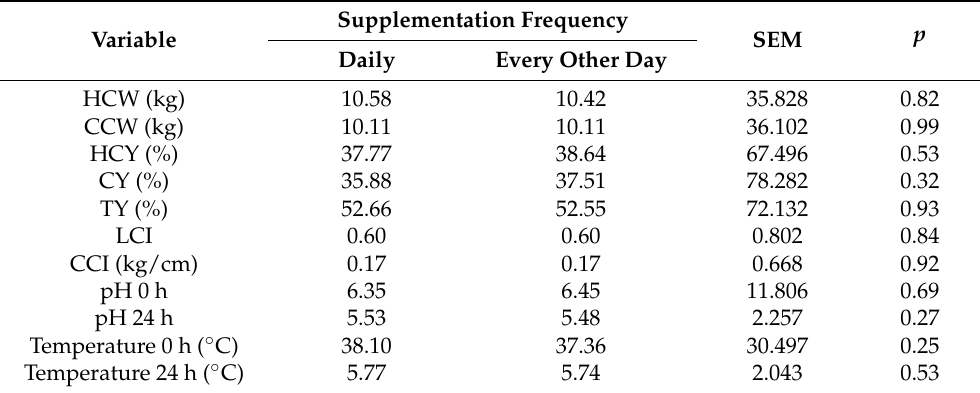
Table 5. Carcass characteristics and yields of sheep submitted to intermittent supplementation on Masai grass pasture.